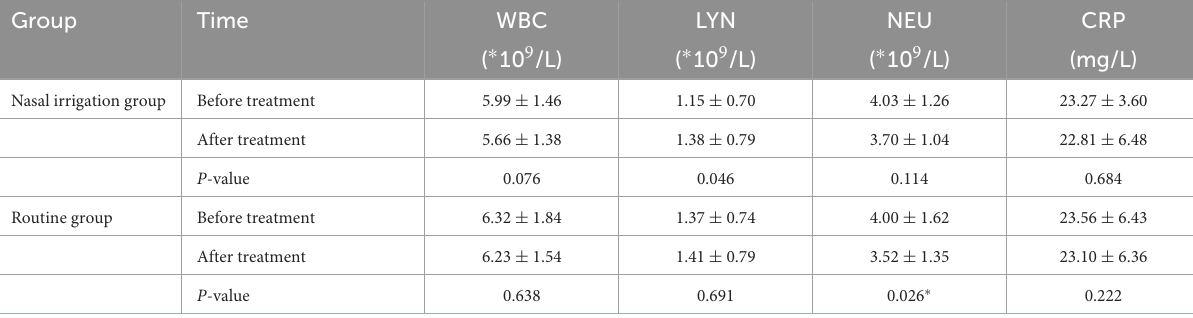
TABLE 4 Changes of blood routine test and CRP indexes in nasal irrigation group and routine group before and after treatment. Group Time